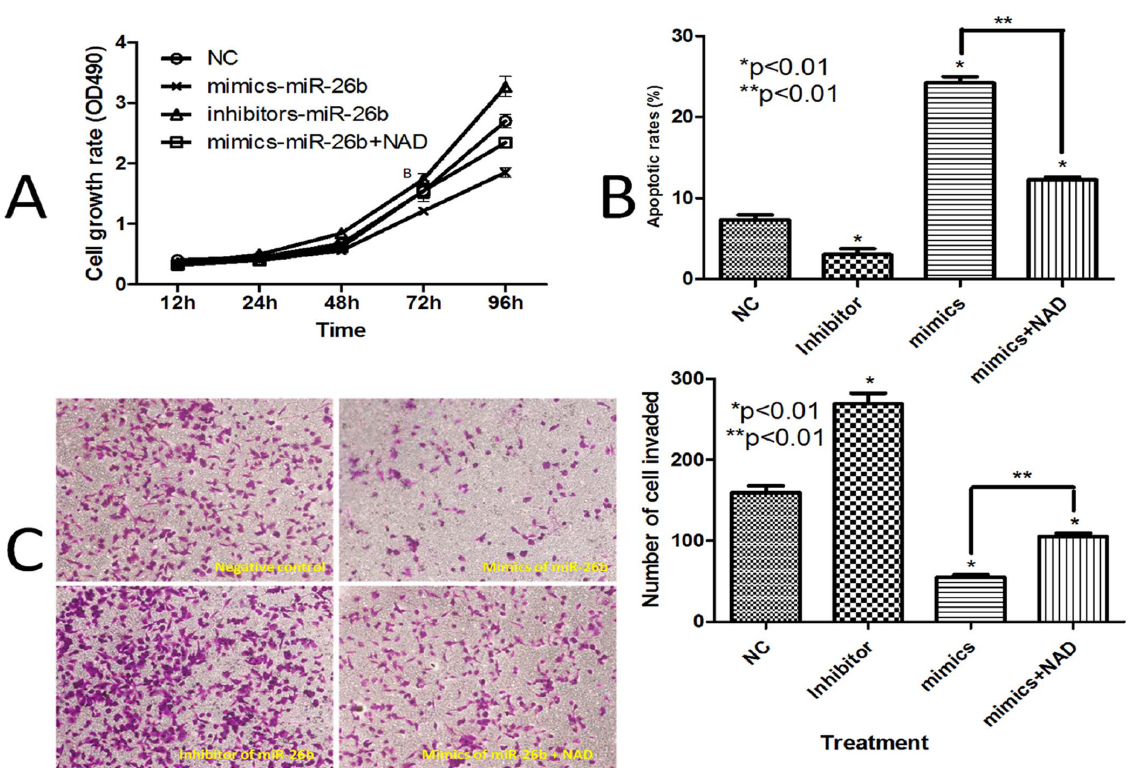
Figure 4. Effects of miR-26b and NAD + on the cell survival and invasiveness of colorectal cancer cells. A. LoVo cells were treated with miR-26b mimics et al., and cell viability was determined using Cell Counting Kit-8. B. The quantification of apoptotic cells induced by miR-26b mimics (with and without NAD) or miR-26b inhibitor was confirmed by flow cytometry analysis. The sub-G1 contents were designated apoptotic cells. C. Representative micrographs of cell invasion assays (left) and the quantification (right) from different treatments (*p , 0.01). The stained invasive cells were photographed under an inverted light microscope (100 6 magnification). *: versus negative control group; **: compared with 2 treatment groups. Each vertical bar represents the mean 6 SD of triplicate determinations. For comparison of 2 groups, a two-tailed, unpaired t-test was